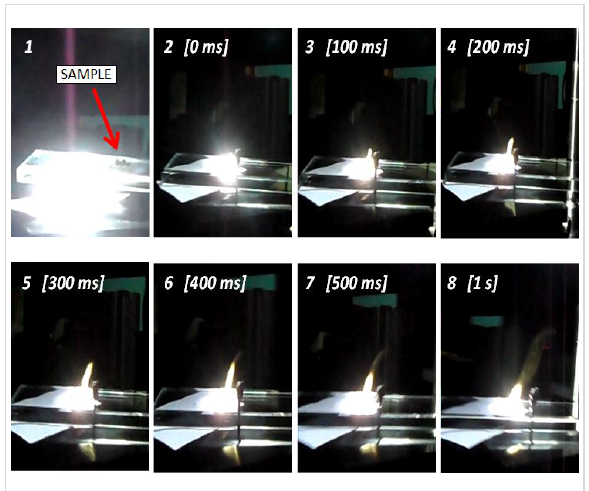
Figure 15: Captured pictures of the combustion process where the MWCNT/ferrocene sample is ignited by illumination of the whole spec- trum of the Xe lamp. The first frame refers to the time just before the sample enters the white light beam path.